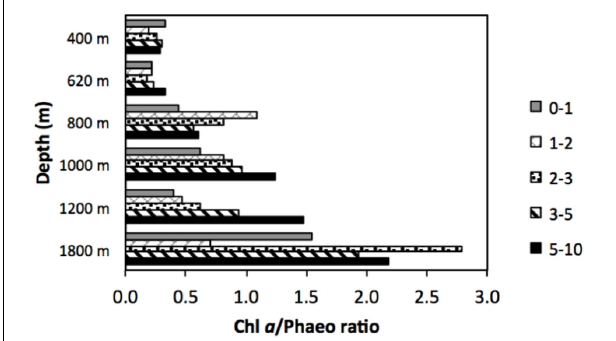
FIGURE 2 | Vertical profile of the ratios of chlorophyll a to phaeopigments (chl a /phaeo) in slope sediments off Costa Rica.